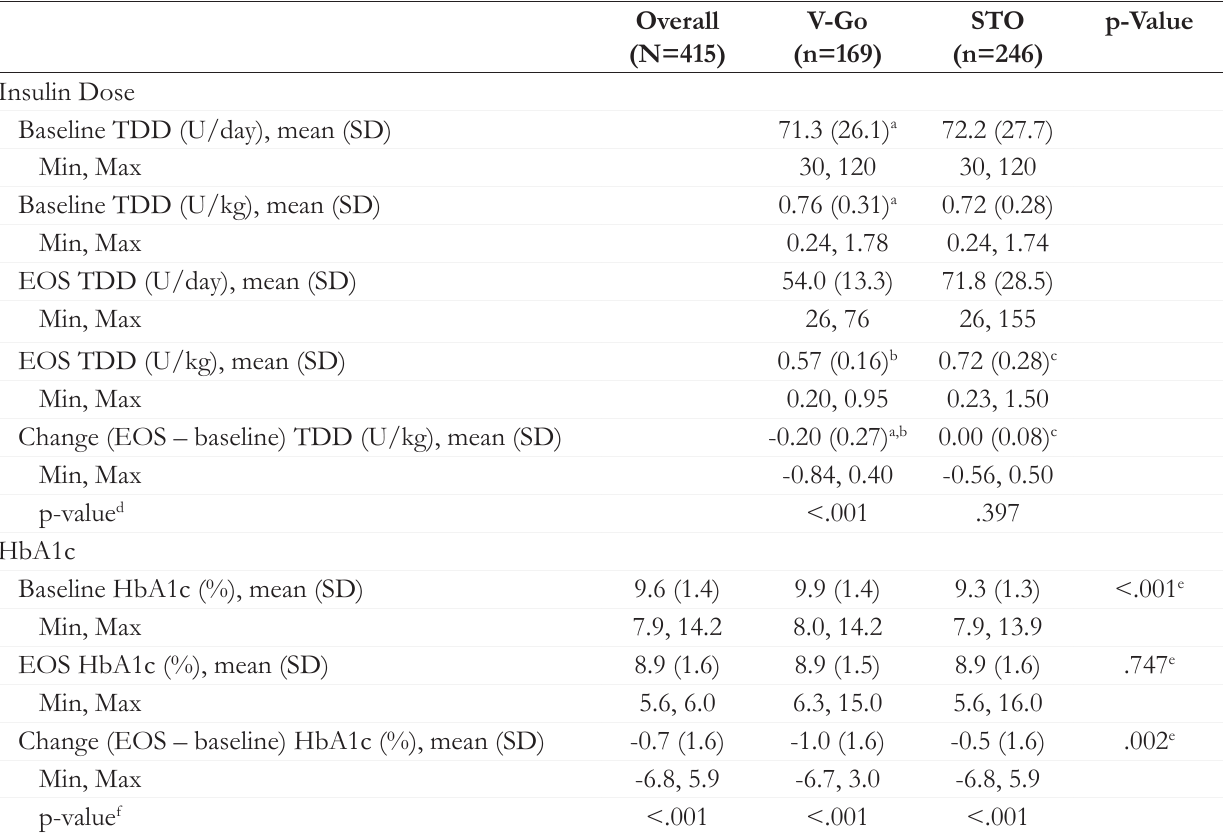
Table 2. Changes in Insulin Use and HbA1c, Baseline to End of Study